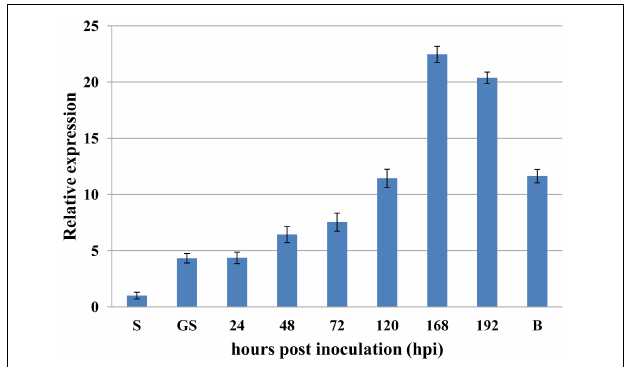
FIGURE 3 | Expression of PsRPs26 during the different infection stages of P. striiformis. The expression levels were normalized by PsEF-1a . S, urediniospores; GS, in vitro germ tube; B, infected Berberis shensiana . Mean expression values were calculated from three independent